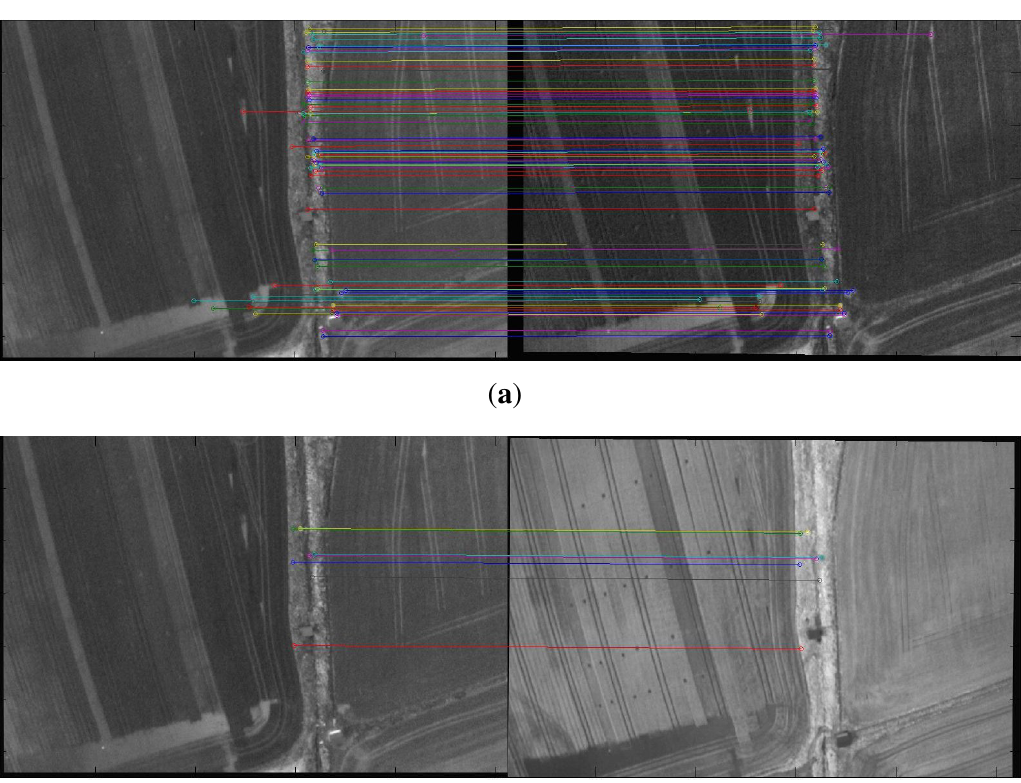
Figure 4. Main Spectral Groups (MSGs) co-registration. The quantitative evaluation (dataset # 6). ( a ) Inliers (number of correspondences: 84) during the co-registration of the 1st and 2nd MSG. Bands: 550.5 nm (left) and 588.6 nm (right) ( b ) Inliers (number of correspondences: 7) during the co-registration of the 2nd and 3rd MSG. Bands: 550.5